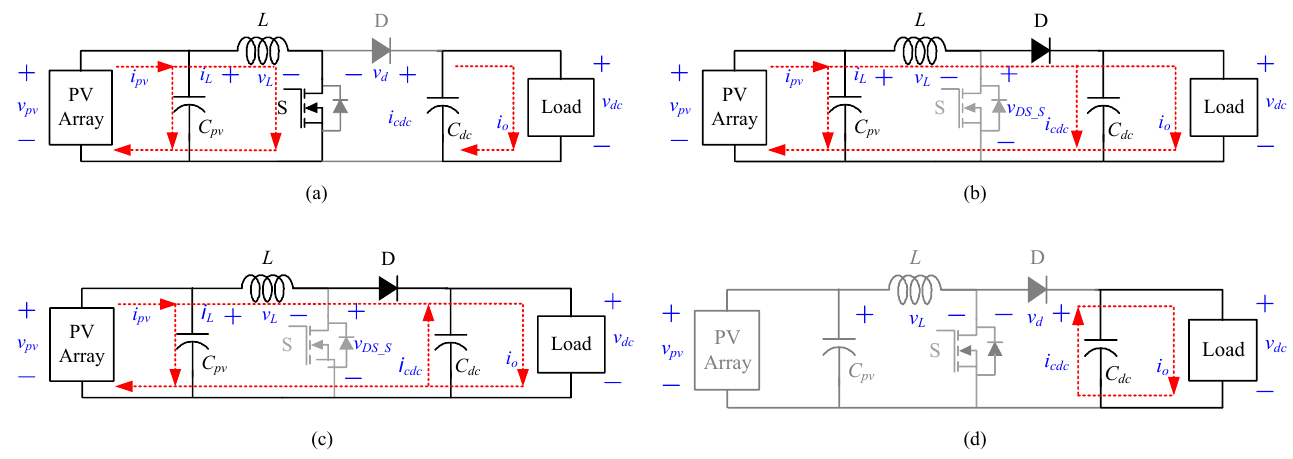
Figure 8. Operation modes of boost converter: ( a ) Mode I, ( b ) Mode II, ( c ) Mode III, and ( d ) Mode